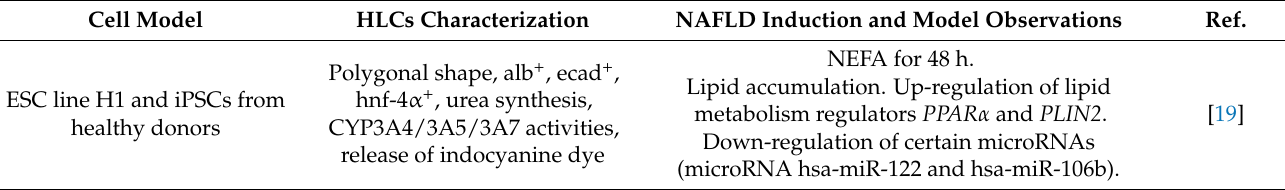
Table 2. Pluripotent stem cell-derived cell models to study